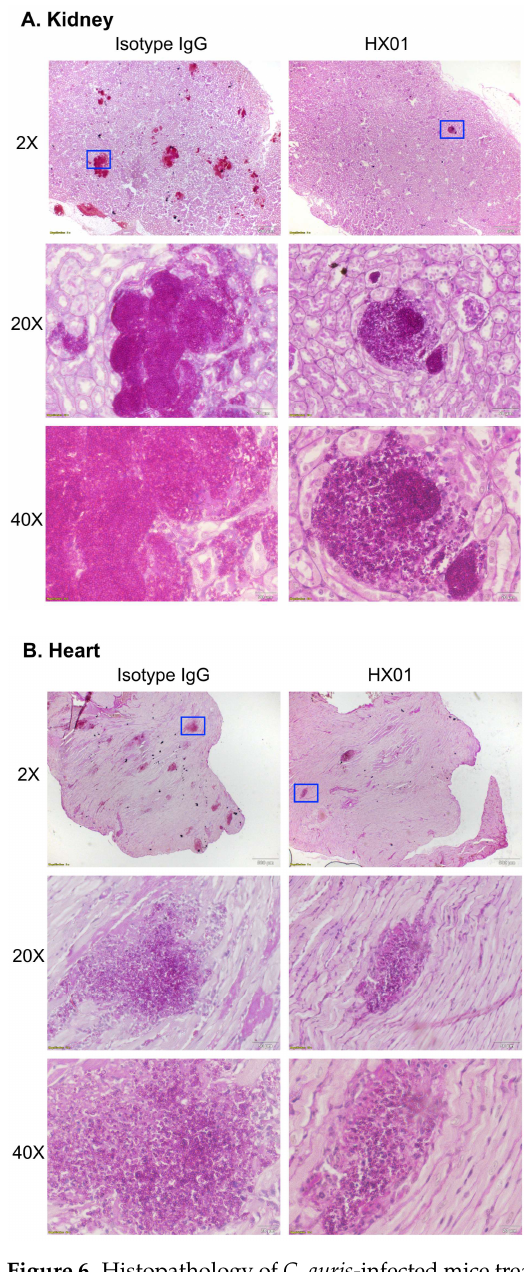
Figure 6. Histopathology of C. auris -infected mice treated with HX01 MAb. Immunosuppressed CD-1 mice were infected intravenously with C. auris CAU-09 (5 × 10 7 cells) and treated with 30 µg/mouse of HX01 MAb or an isotype-matched control IgG1 (i.p.) on day +1 post-infection. Mouse kidney ( A ) and heart ( B ) histopathology sections were stained with PAS and imaged using Olympus bright field microscopy. Blue boxes in top panels represent areas magnified at 20× and 40× in the middle and lower panels, respectively.